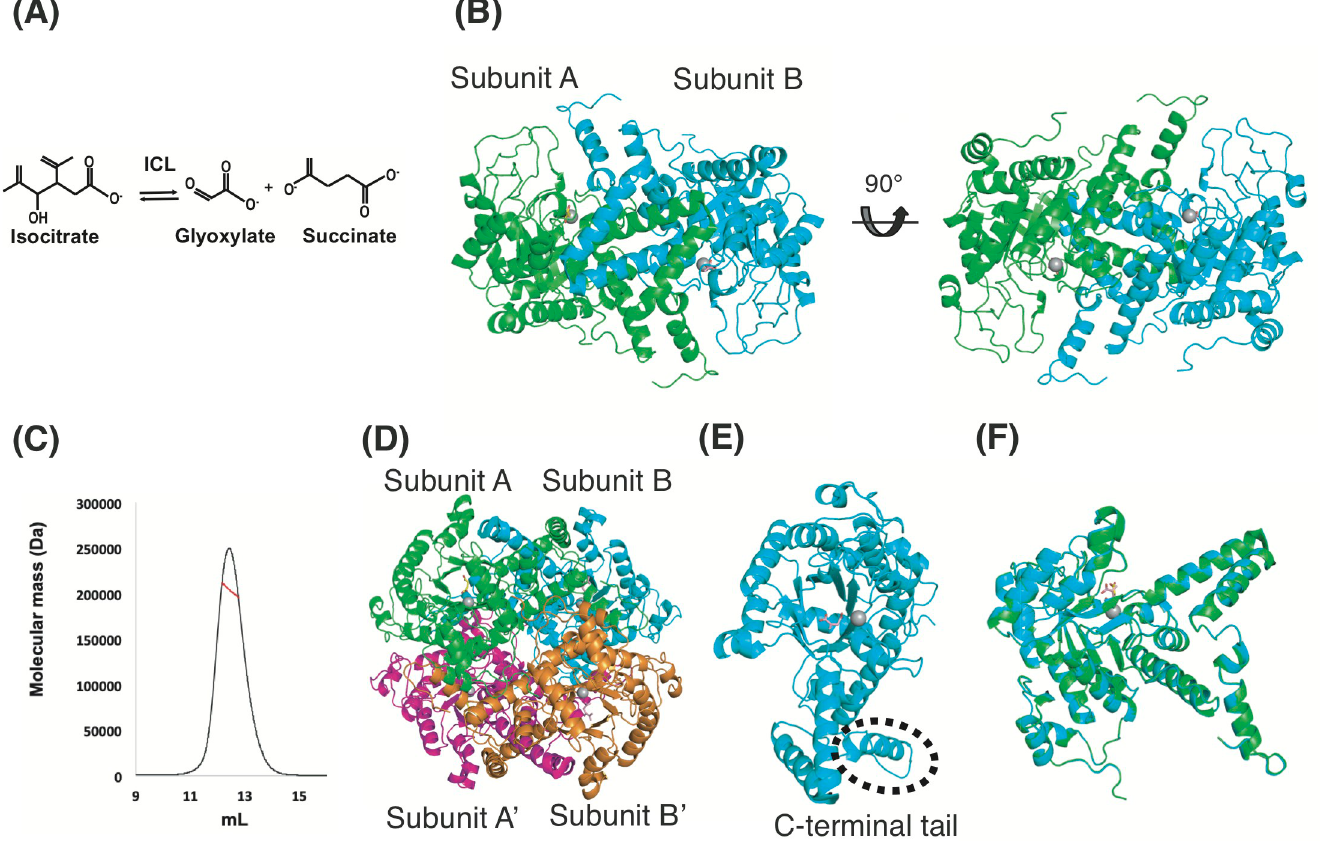
Fig 1. Overall structure of tbICL in complex with succinate and itaconate. (A) Reversible catalytic reaction of tbICL, involving isocitrate, glyoxylate, and succinate. (B) Crystal structure of tbICL in the asymmetric unit. The two molecules (subunits A and B) are represented graphically from two different viewpoints. The gray spheres, yellow stick (subunit A), and pink stick indicate Mg 2+ ions, succinate, and itaconate, respectively. (C) SEC-MALS profile of tbICl. Measured values using SEC-MALS (red) are plotted as SEC elution volume (x-axis) versus absolute molecular mass (y-axis) distributions on the SEC chromatogram (black) at 280 nm. (D) Tetrameric structure of tbICL. Two 2fold symmetric neighboring molecules (magenta and orange) were identified and modeled with the dimeric structure in the asymmetric unit. (E) The monomeric structure of tbICl (subunit B). (F) Superimposition of subunit B onto subunit A of